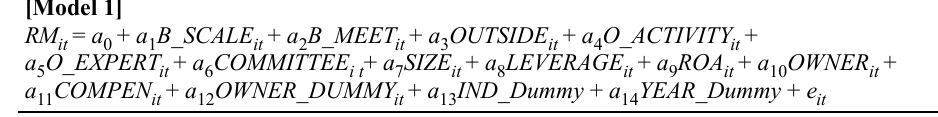
Table 4. Regression of earnings management on corporate governance (OLS regression) [Model